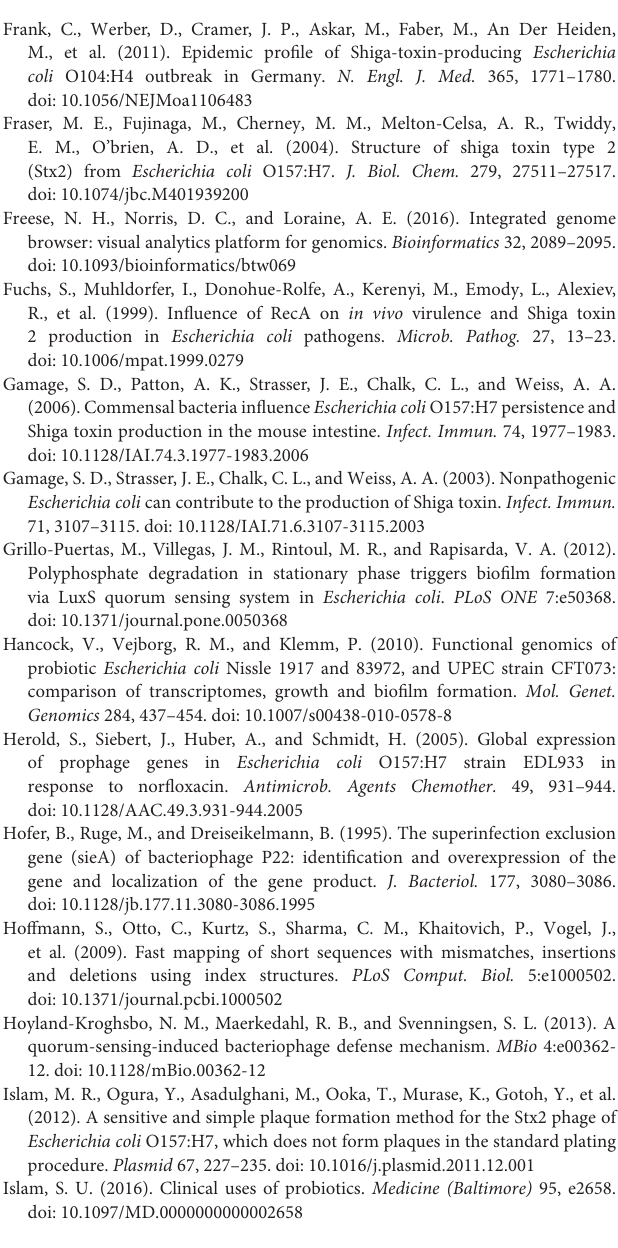
Figure S1 | Gene regulations in the predicted prophages of EcN in presence of stx- phage. Figure S2 | Alignment of the amino acid sequence of the lambda phage (LamB) and stx- phage (YeaT) receptors of EcN with MG1655. Figure S3 | Growth determination of MG1655. MG1655 was cultured alone in LB Medium (MG1655) or with (A) lambda-phages (1:10) and